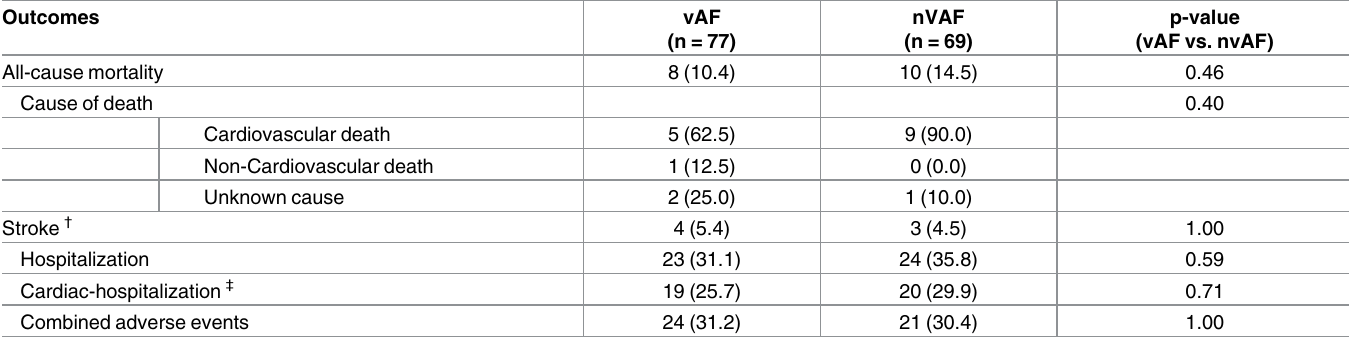
Table 3. Comparison of outcomes of atrial fibrillation